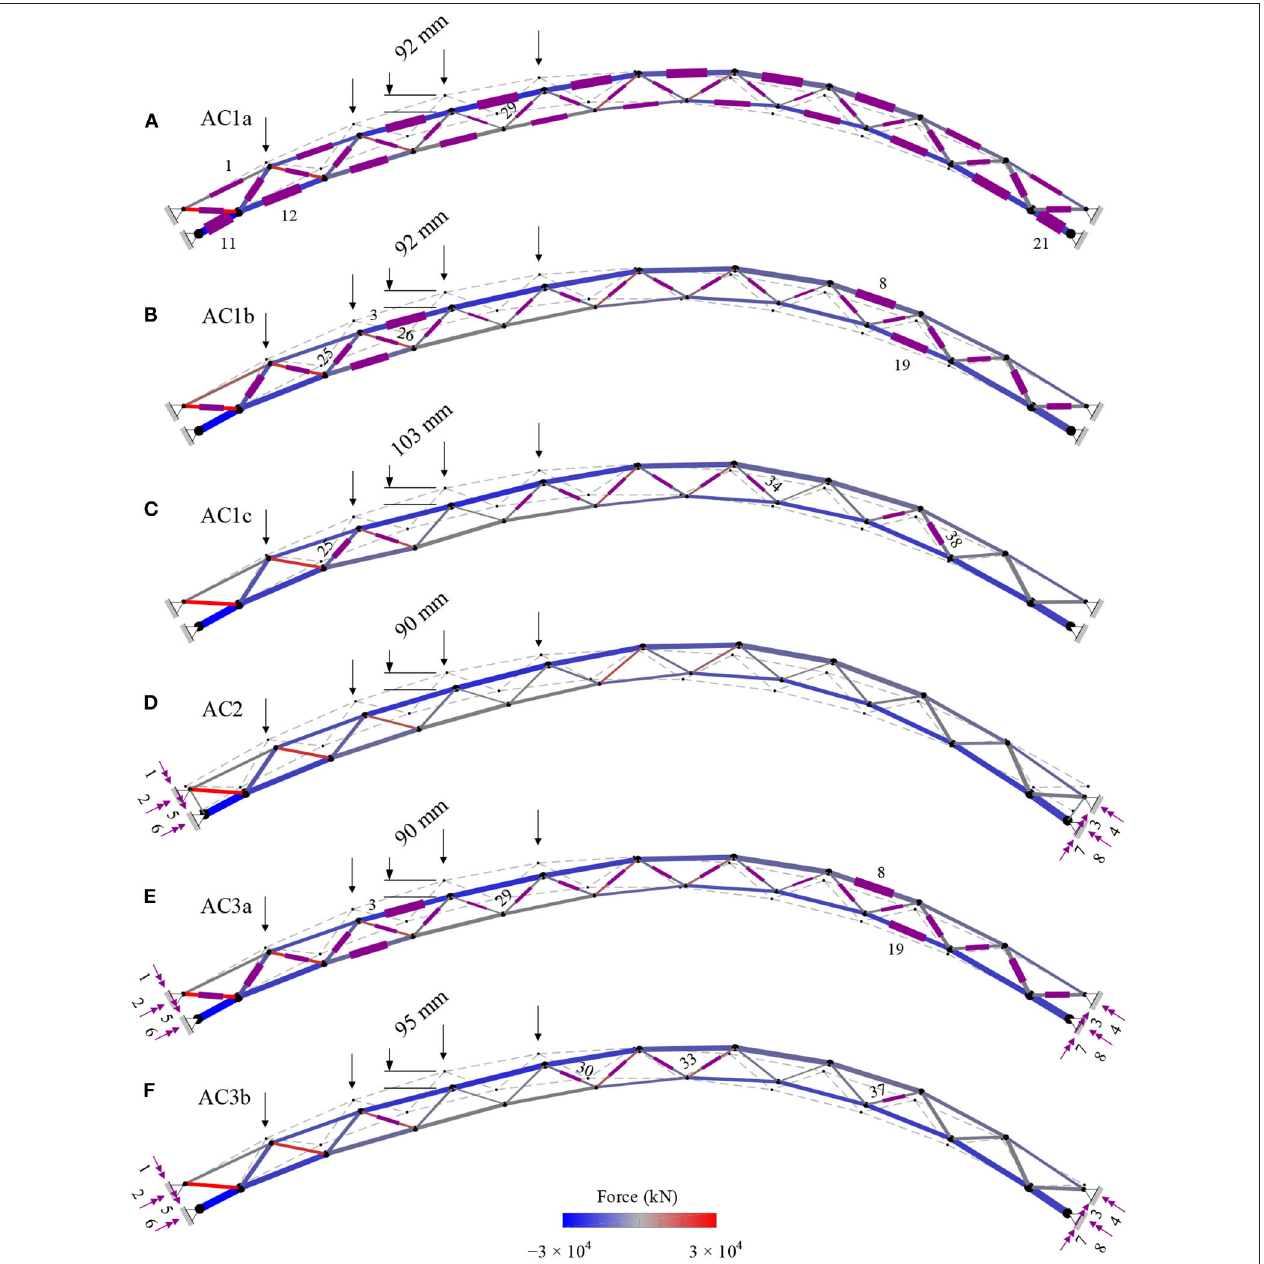
FIGURE 5 | Arch bridge: actuator layout, element forces, and controlled shapes (magnification × 20) under LC2 for AC1a-c (only internal actuators), AC2 (only external actuators) and AC3a-b (combination of internal and external actuators).